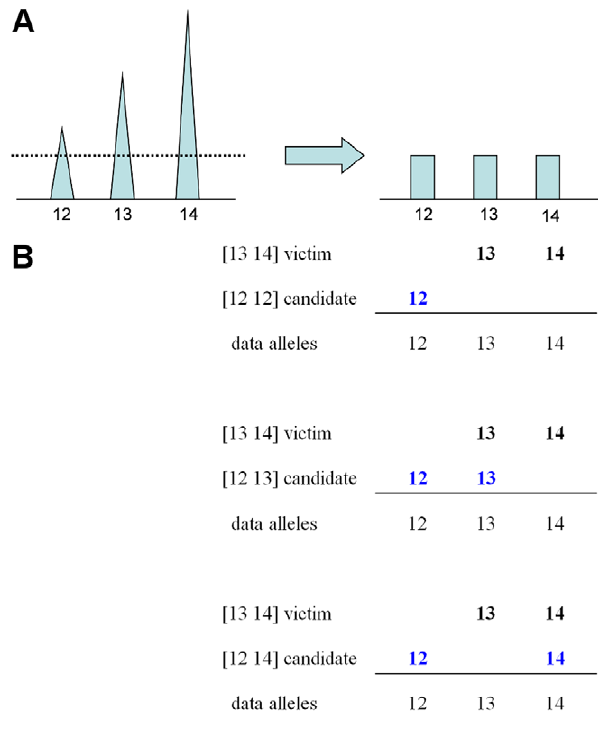
Figure 4. Qualitative genotype inference uses thresholds to discard data and produce a uniform genotype probability distribution. In qualitative genotype interpretation, a predetermined threshold is applied to the peak height data, retaining all peaks whose heights exceed the threshold, and discarding all other peaks. (a) This threshold operation transforms the quantitative peak height pattern into a qualitative all-or-none set of threshold-inferred alleles. (b) This data allele set can then be compared with victim (black) and candidate culprit (blue) genotype values in a match operation based on qualitative set inclusion. When accounting for the victim’s genotype, all possible culprit allele pairs that combine with the victim’s alleles to reproduce the data alleles are assigned equal positive